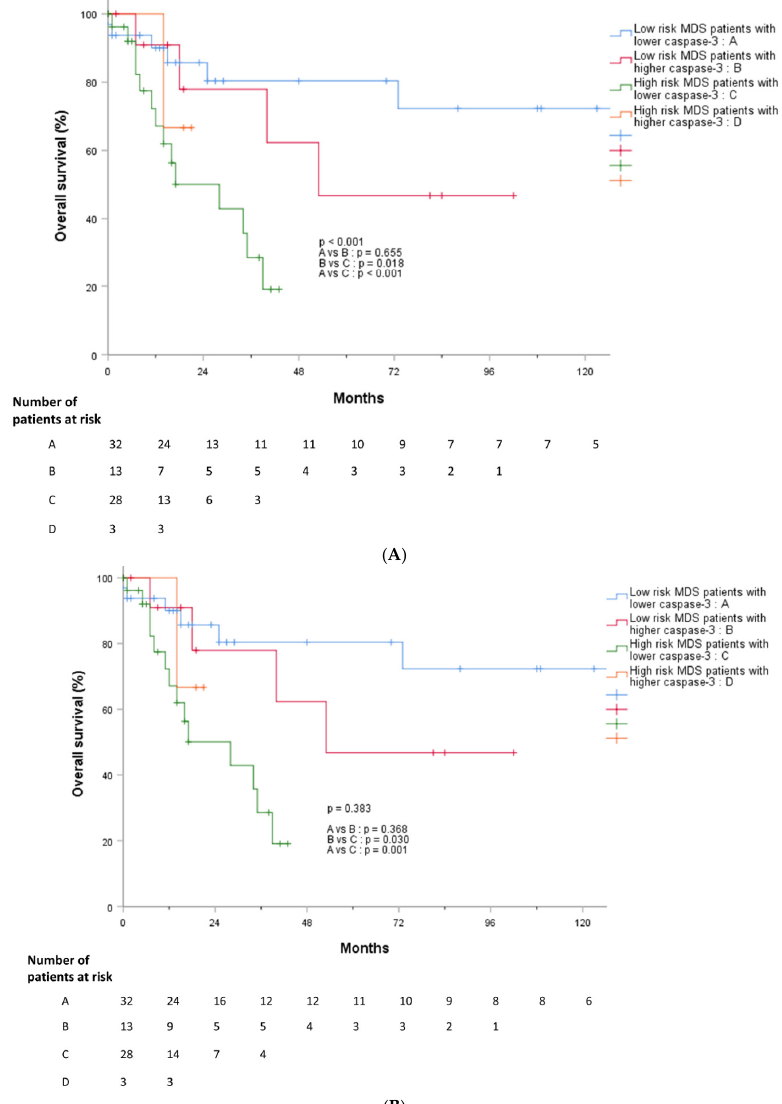
Figure 8. ( A ) Overall survival according to cleaved caspase-3 and IPSS-R risk stratification. Abbreviation: IPSS-R, Revised international prognostic scoring system; MDS, Myelodysplastic syndrome; ( B ) Overall survival according to Ki-67 and IPSS-R risk stratification. Abbreviation: IPSS-R, Revised international prognostic scoring system; MDS, Myelodysplastic syndrome;